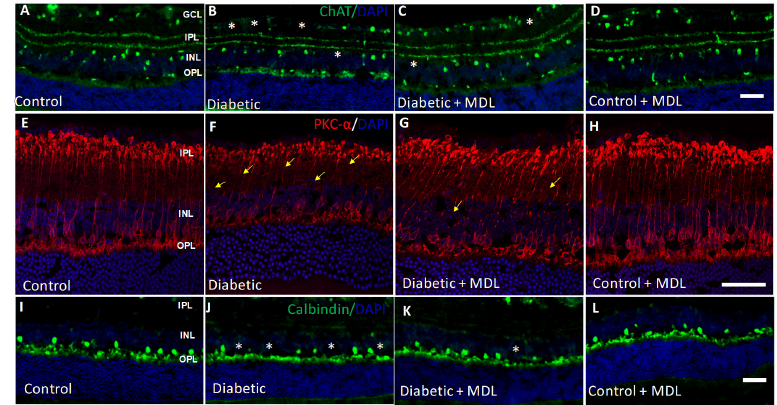
Figure 6. Treatment with MDL 72527 reduced neurodegeneration in the diabetic retina. A–D ) Immunostaining of retinal cryostat sections using the ChAT antibody showing loss of amacrine cells in the diabetic retina (16 weeks), compared to control. E–H) Immunostaining using PKC α , a marker for rod bipolar cells demonstrates the presence of degenerating axons and synaptic ends in the diabetic retina. I–L) Immunofluorescence images showing the loss of horizontal cells in the diabetic retina by calbindin immunoreactivity. MDL 72527 treatment markedly reduced the neurodegenerative changes. Asterisks indicate areas of cell loss, and arrows indicate areas of axonal degeneration. N = 5–6 per group and representative images are presented. Scale bar 50 µm.